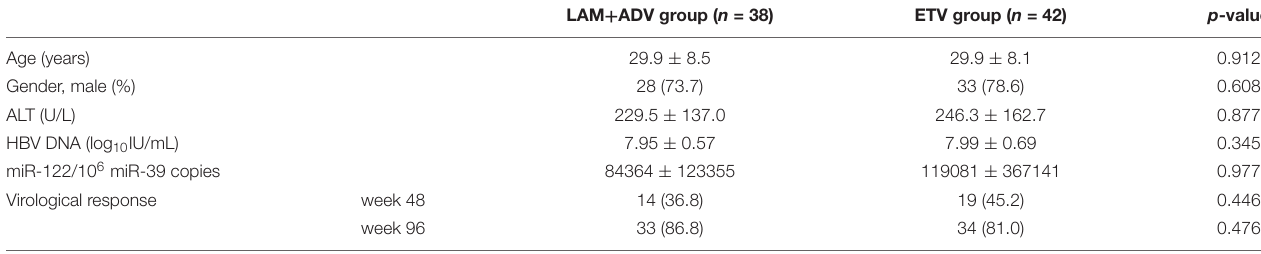
TABLE 1 | Patient characteristics.